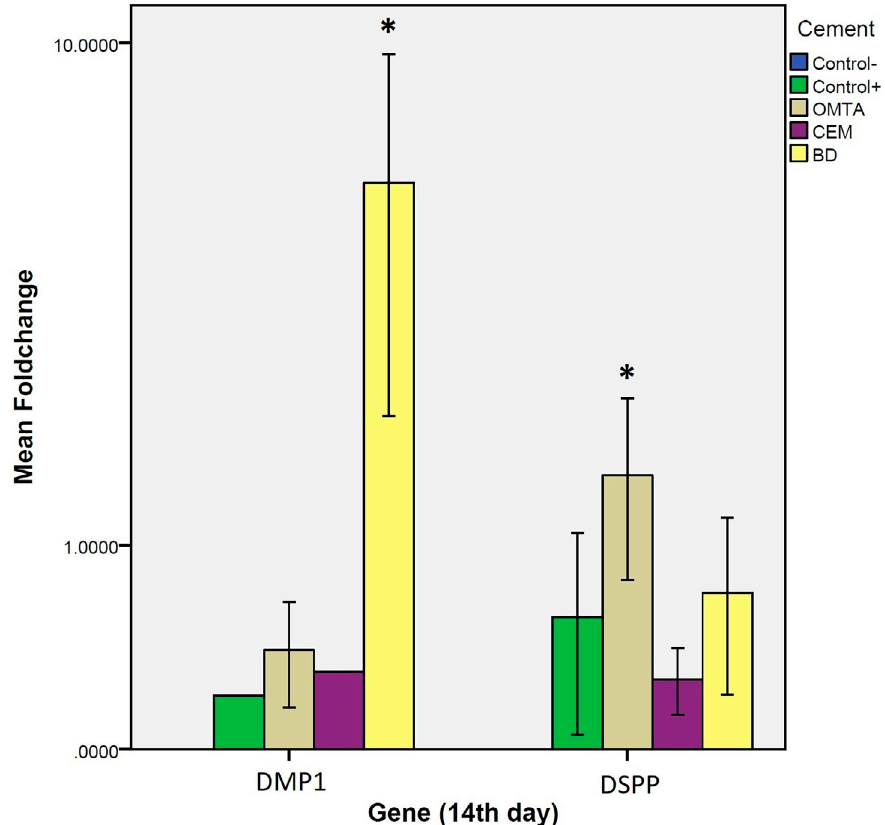
Figure 6- Real-time PCR test results comparing gene expression of DSPP and DMP1 induced by the test materials on day 14. One-way ANOVA test indicated a significant difference in expression of DSPP and DMP1 genes between test materials on day 14. Tukey HSD test indicated that BD significantly increase expression of DMP1 and OMTA significantly increased DSPP gene expression